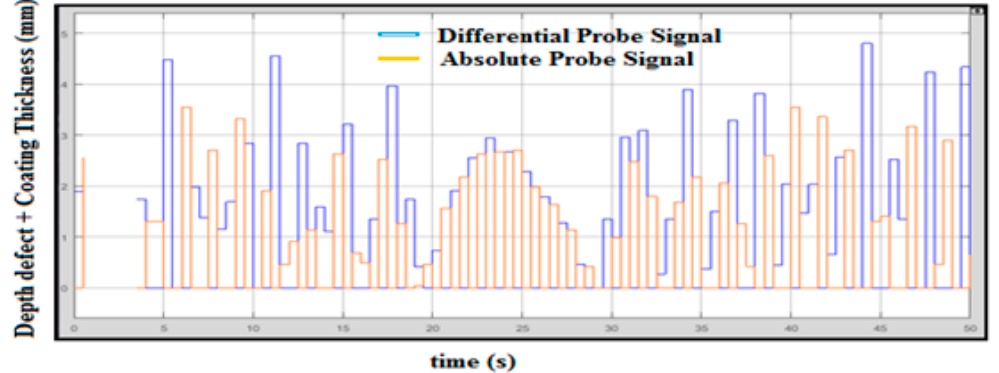
Figure 11. Integrated Probe Output with Coating Thickness.